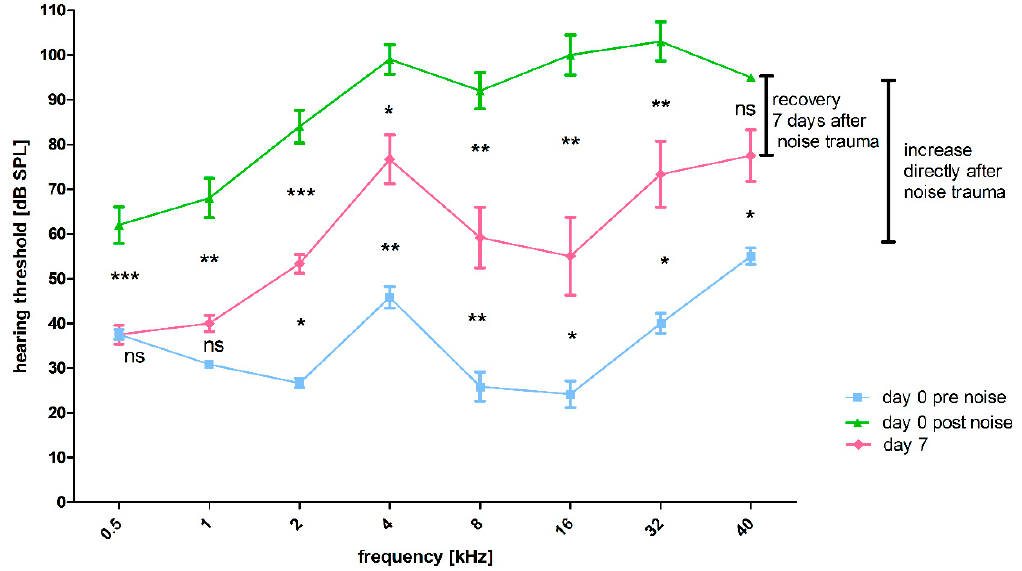
Figure 9. Effect of noise exposure on ABR pure tone thresholds in not implanted ears over time. Hearing thresholds of the right (not implanted) ears. Where the hearing threshold could not be identified up to the maximum sound stimulus level of 100 dB SPL (85 dB SPL for 40 kHz), the thresh ‐ old was defined as 110 dB SPL or 95 dB SPL for 40 kHz. Directly after the noise insult, all thresholds increased significantly, except for 500 Hz and 1 kHz (blue line vs. green line, not illustrated). In addition, 7 days after the noise insult, there is significant frequency ‐ specific recovery, except for 40 kHz (significances illustrated between the green and the red line). The remaining significant thresh ‐ old shift from day 0 pre noise to day 7 was also frequency specific, except for 500 Hz, which showed a full recovery and 1 kHz (significances illustrated between the red and the blue graph). ns = not significant; * p ≤ 0.05; ** p ≤ 0.01; *** p ≤ 0.001.